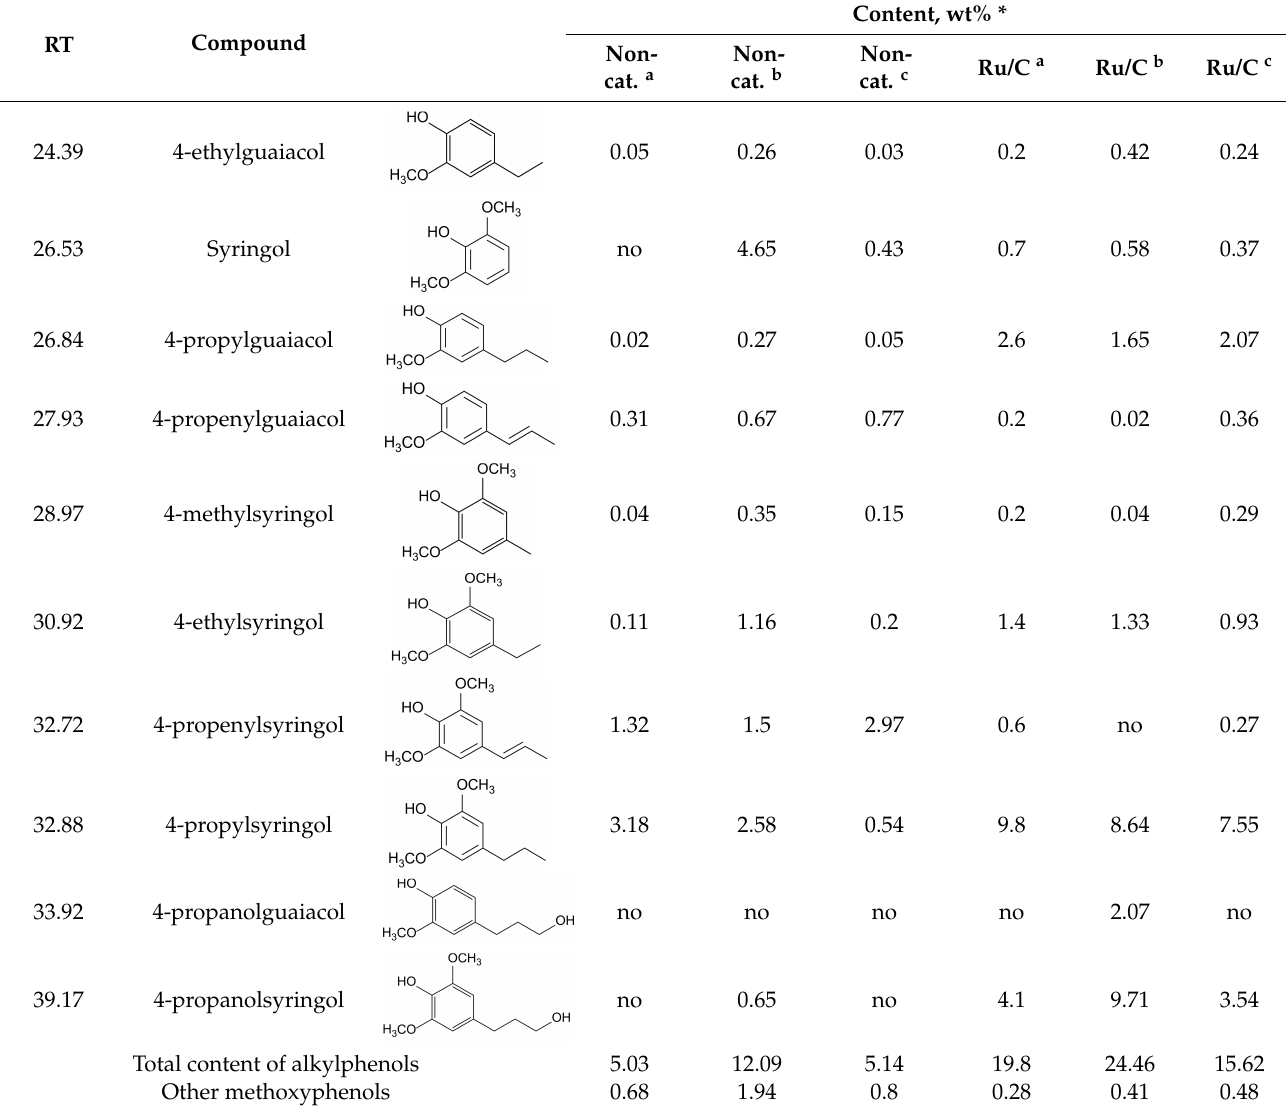
Table 5. Composition and content of phenolic compounds in liquid products of hydrogenation of initial ( a ), alkali-treated ( b ) acid-treated ( c ) birch wood.